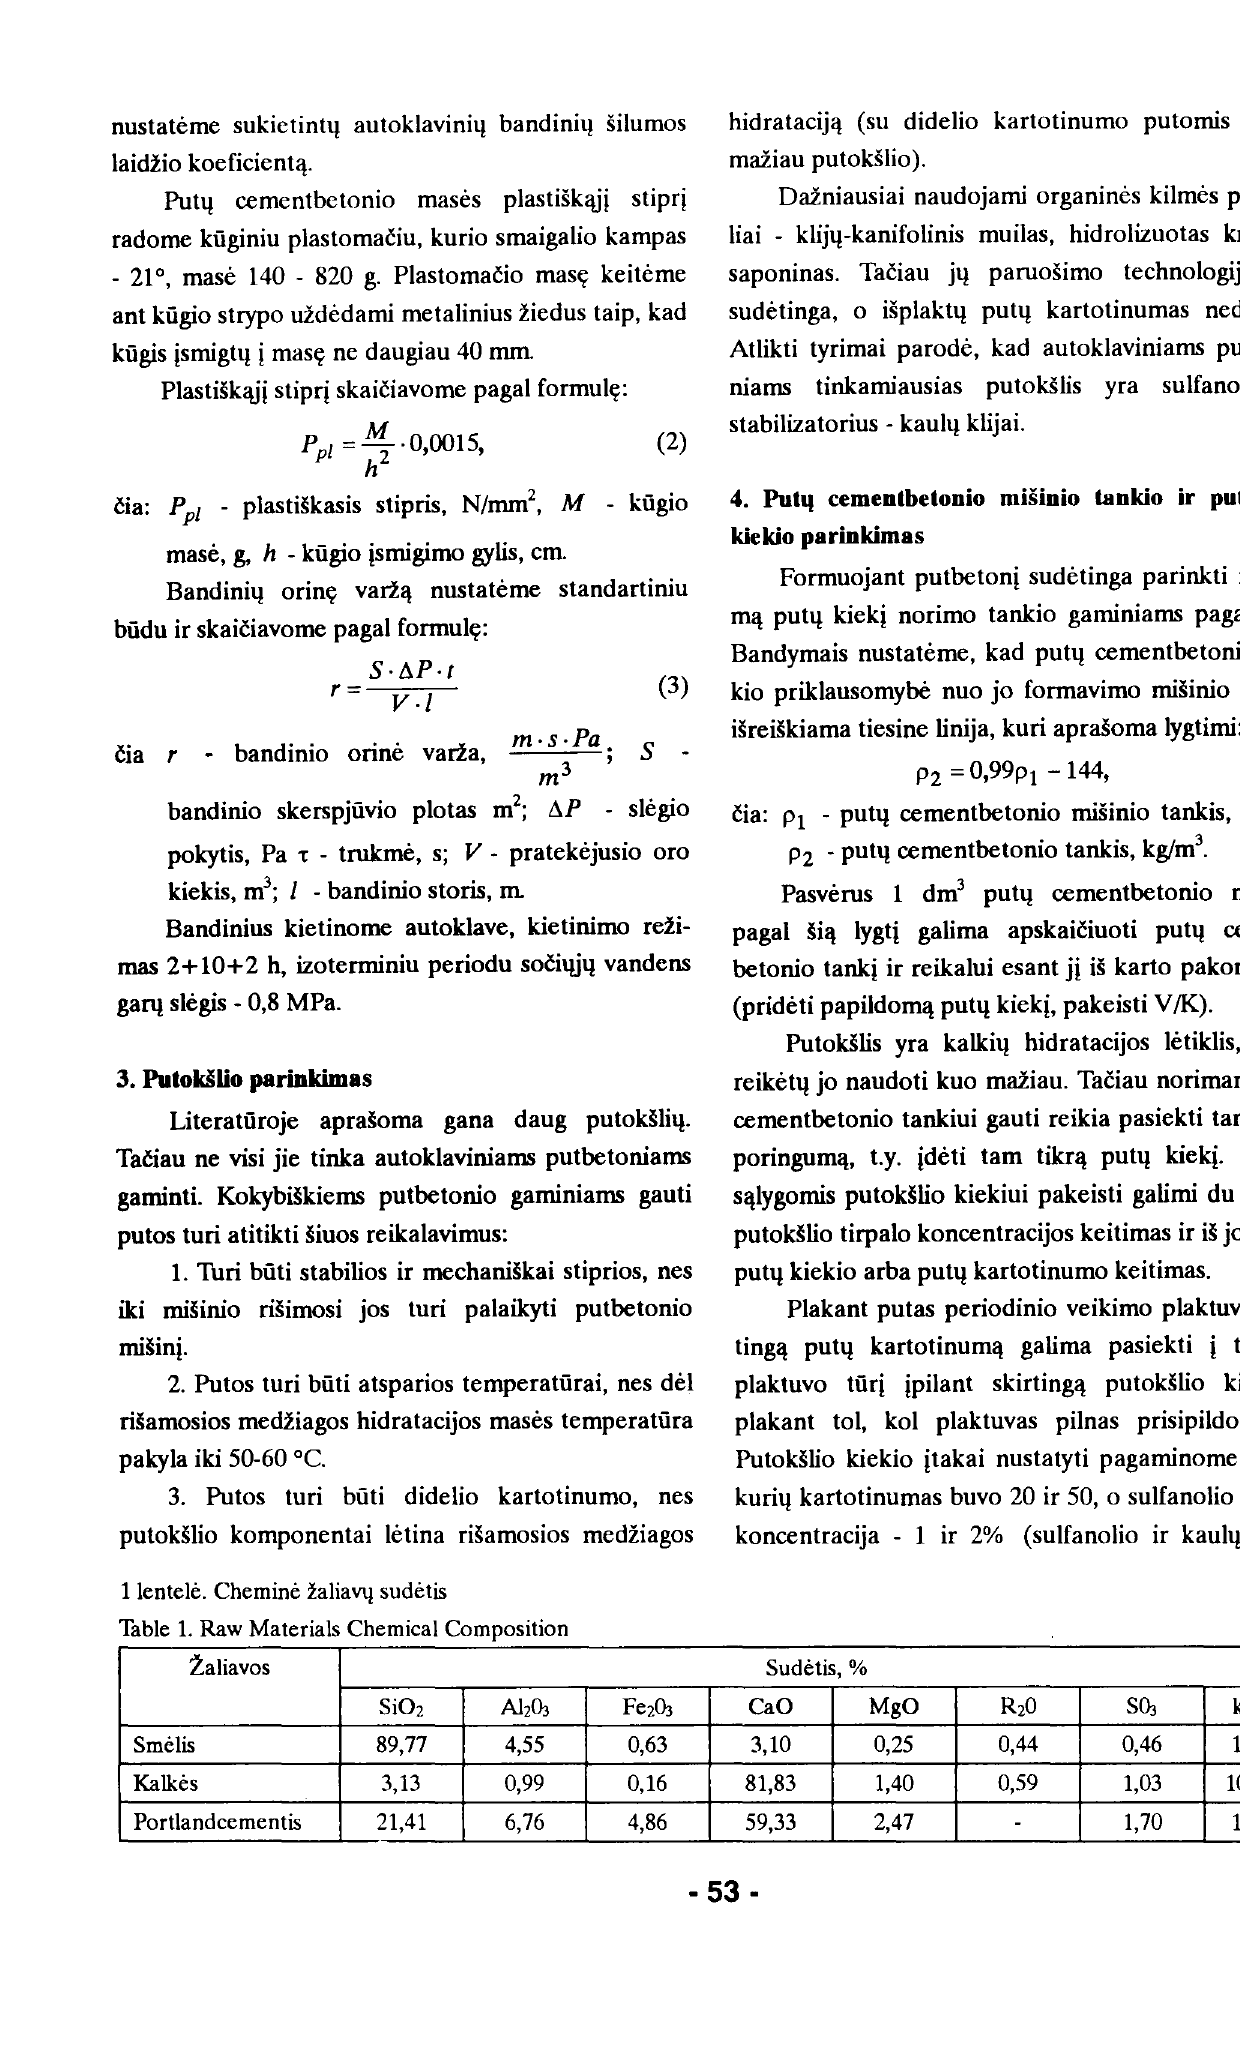
Table 1. Raw Materials Chemical Composition Zaliavos SiOz AlzD.J